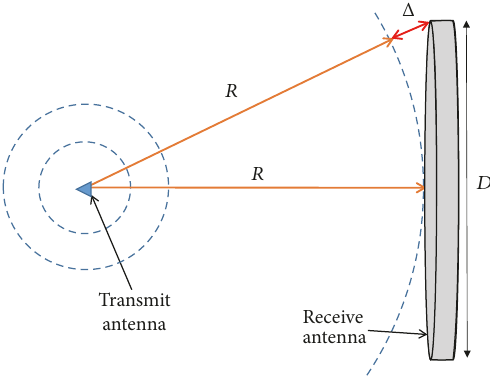
Transmit antenna